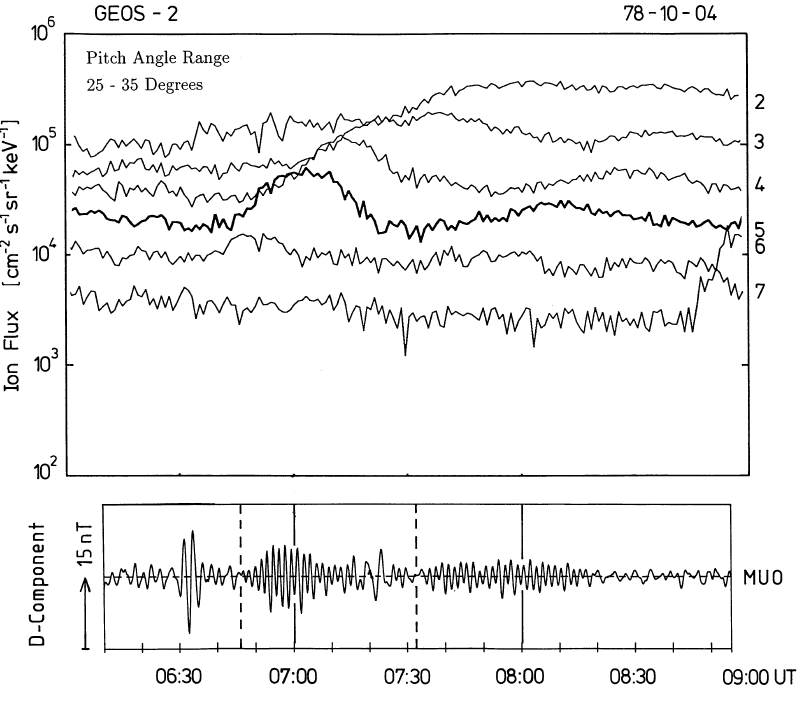
Fig. 5. Proton-Flux measurements made onboard the geostationary satellite GEOS-2 in the pitch-angle range 25 (cid:14) (cid:255) 35 (cid:14) on October 4, 1978, 06–09 UT ( upper panel ), and Earth magnetic field variations of the D-component at the station MUO ( profile 4 ), close to the nominal footpoint of the GEOS-2 field line ( bottom panel ). The flux measurements are shown for six di(cid:128)erent energy channels; channel 2: 28–36 keV; 3: 36–49 keV; 4: 49–59 keV; 5: 59–75 keV; 6: 75–98 keV; 7: 98–114 keV. The magnetic field observations have been filtered in the range